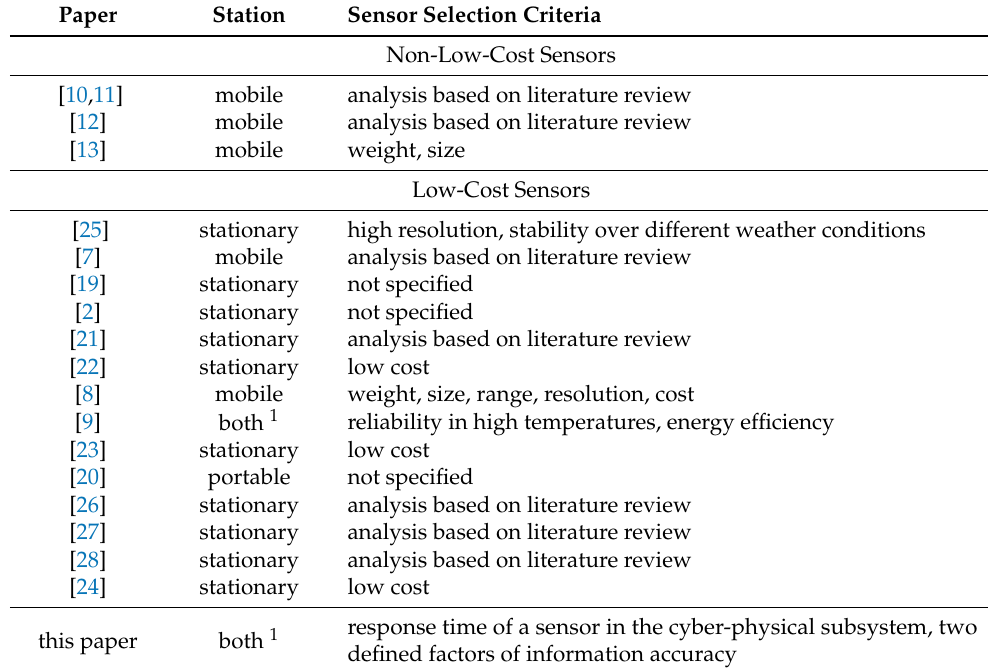
Table 1. Sensor selection criteria in the available literature.